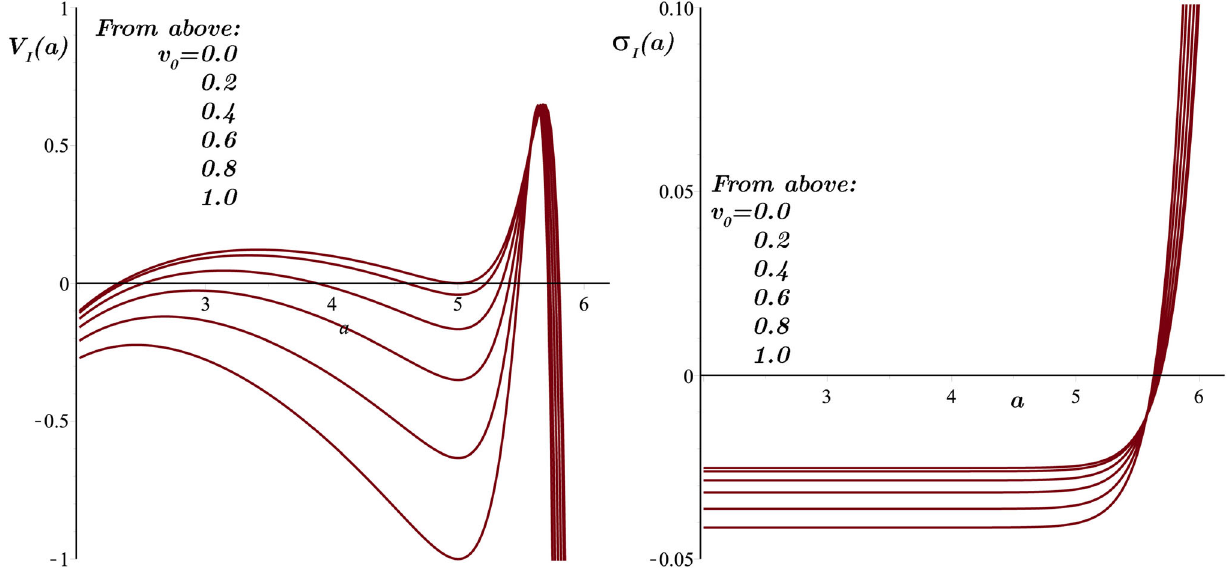
= − 16, M = 1 and from above v = 0 . 0 , 0 . 2 , 0 . 4 , 0 . 6 , 0 . 8 and 1 . 0. Similar to Fig. 1, the 0 0